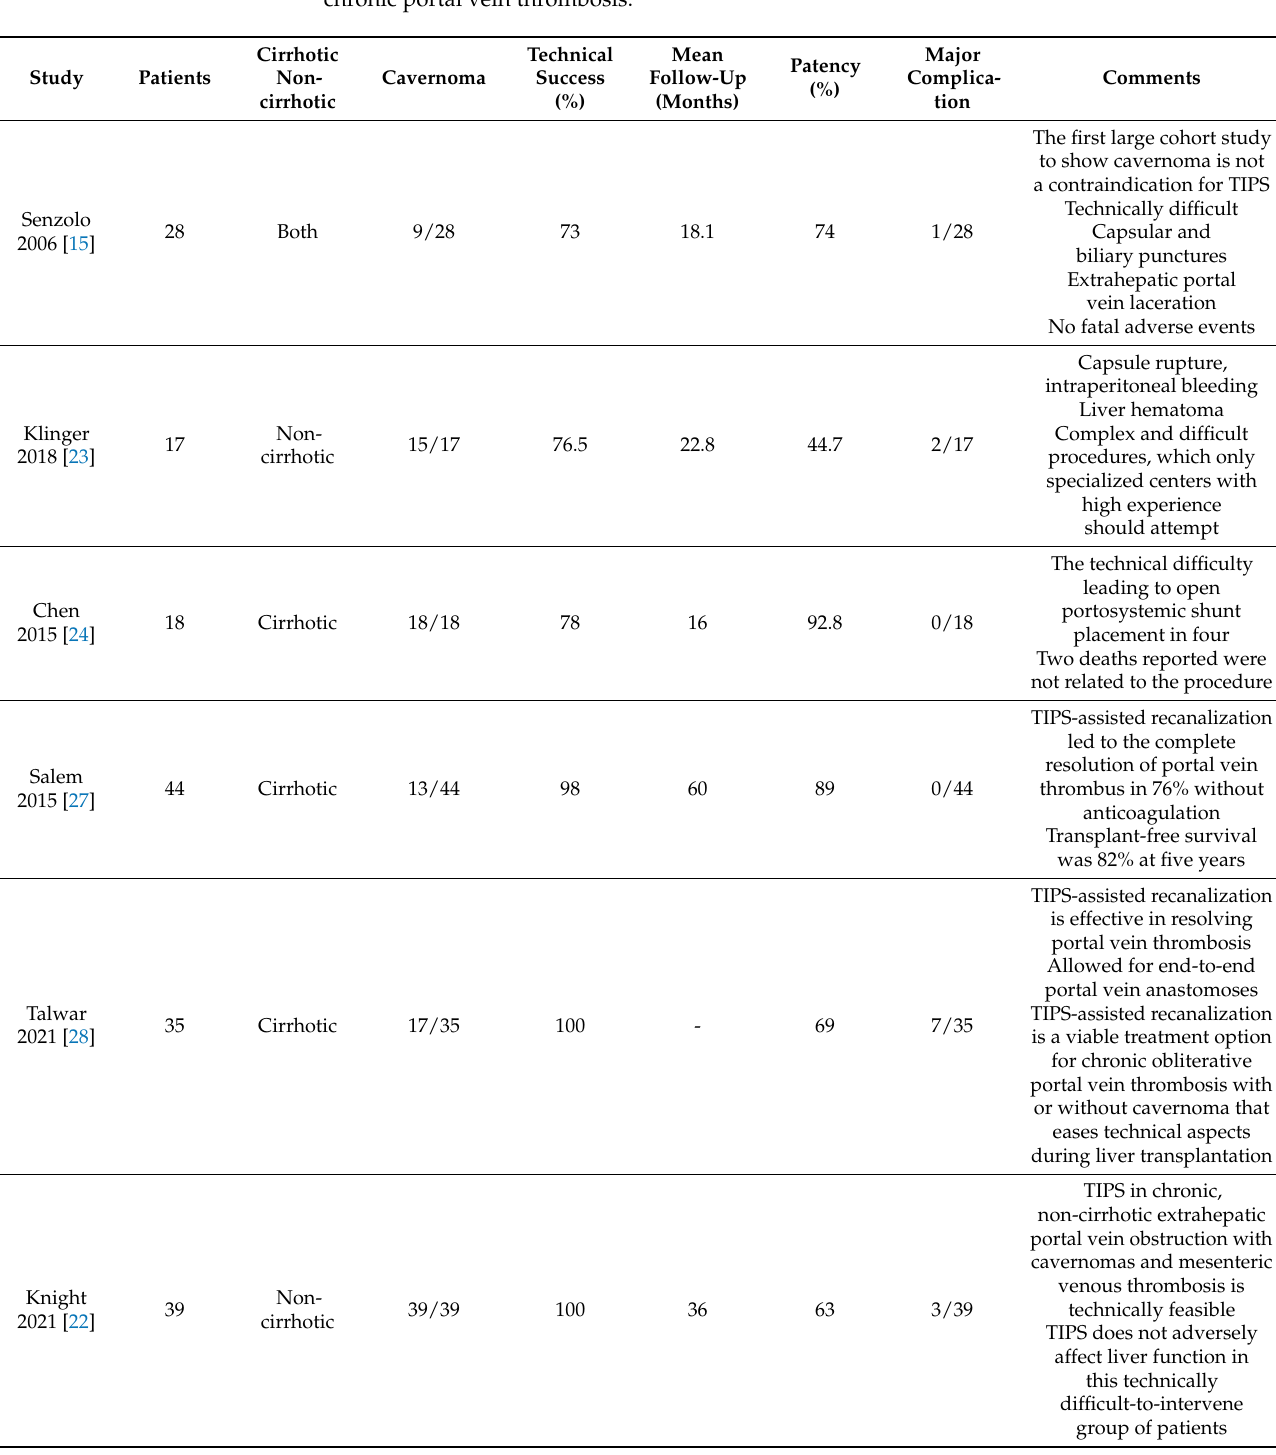
Table 1. Summary of major studies on transjugular intrahepatic portosystemic shunt placement in chronic portal vein